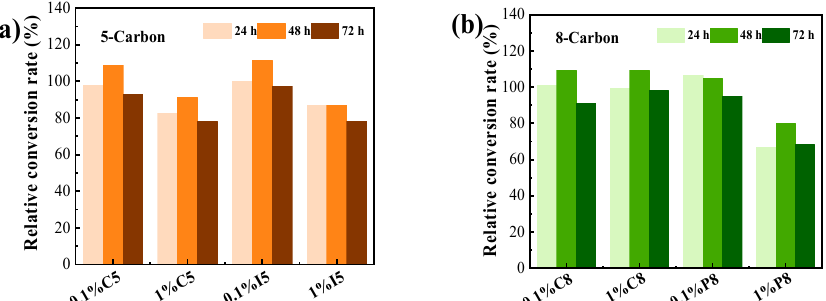
Figure 1. Effects of organic alcohol isomers on enzymatic hydrolysis of Avicel ( a ) isomers of 5-carbon; ( b ) isomers of 8-carbon. Organic alcohol isomers were supplemented at 0.1% ( v / v ) or 1% ( v / v ). Relative conversion rate was standardized by the experiment without additives. (C5—n-pentanol; I5—isoamyl alcohol; C8—n-octanol; P8—phenyl ethanol).